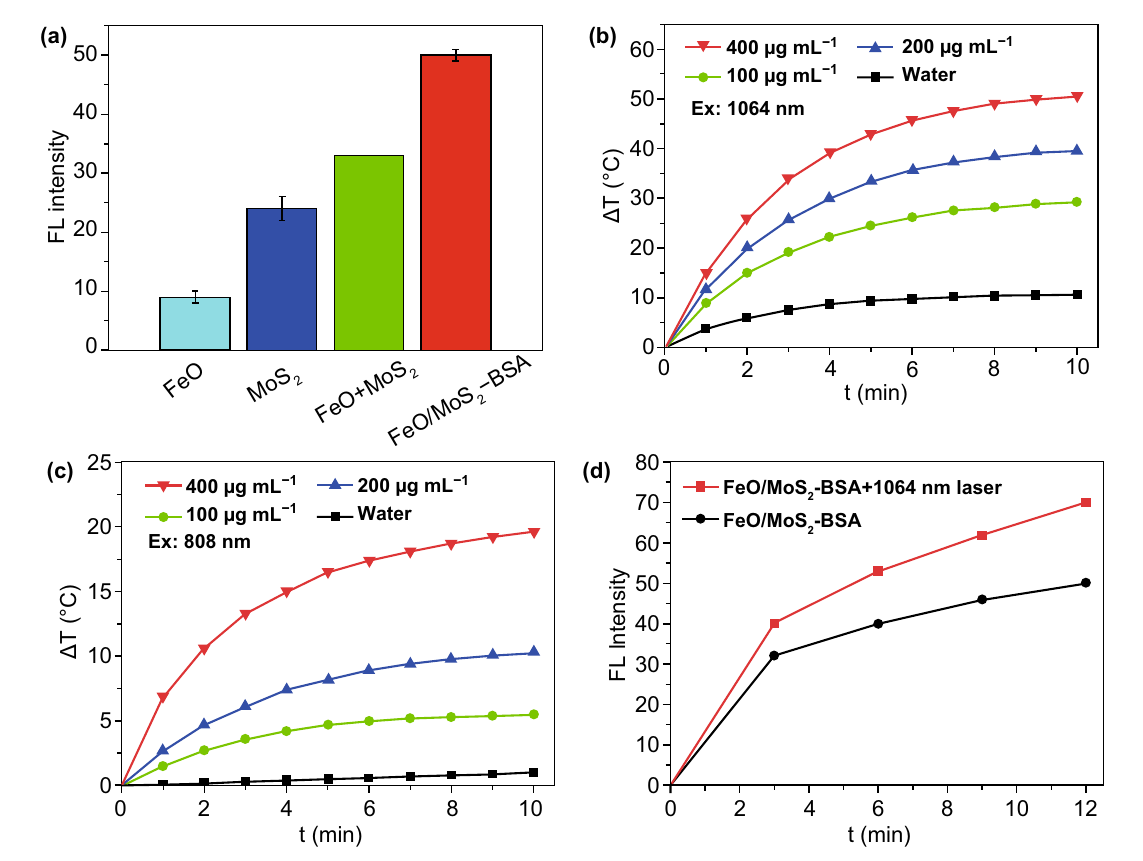
Fig. 2 a •OH production capacity of FeO, MoS 2 , MoS 2 + FeO, and FeO/MoS 2 -BSA solutions mixed with H 2 O 2 . b , c Temperature curves of different concentration FeO/MoS 2 -BSA under irradiation with 1064 nm and 808 nm laser (1 and 0.3 W cm −2 separately). d PT-enhanced •OH generation of FeO/MoS 2 -BSA nanocomposites with or without 1064 nm laser irradiation (0.75 W cm −2